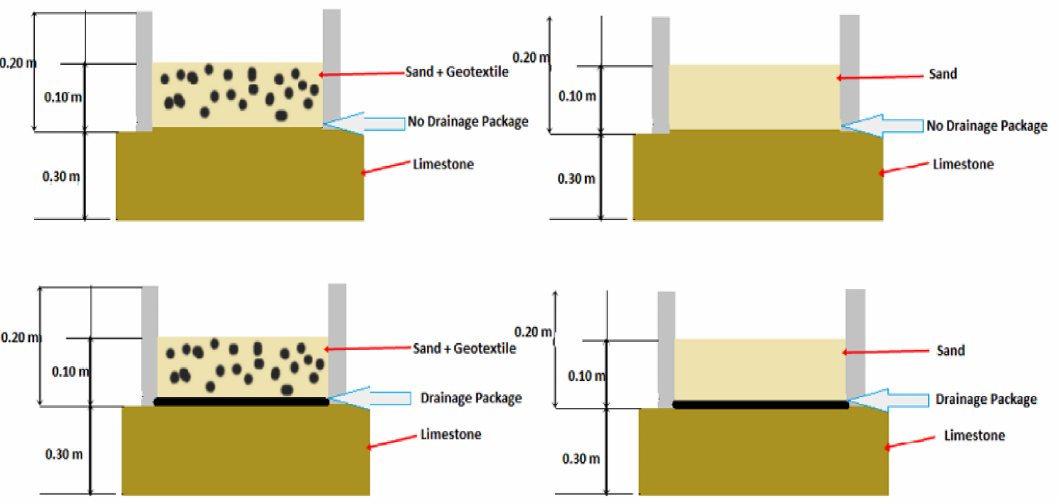
Figure 2. Scheme of box designs including the depth of the top cushion material consisting of sand (G1) or sand with geotextile (G2) over limestone (D1) or over drainage package